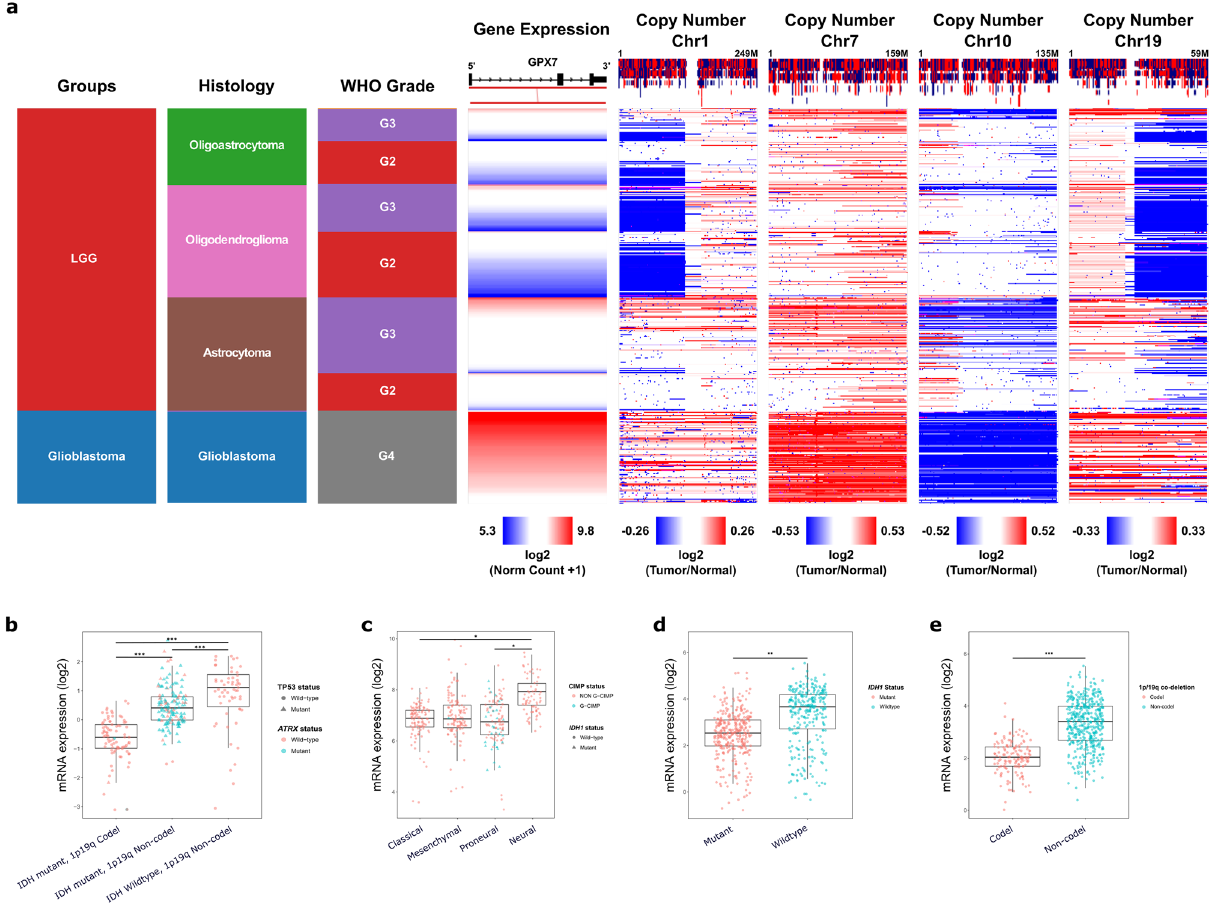
Figure 3. GPX7 expression was correlated with CNAs (Copy Number Alterations), IDH1 mutational status and 1p/19q co-deletion. ( a ) Heatmap integrating GPX7 expression (Log2—Norm Count + 1), CNAs (Copy Number Alterations) status (Log2—Tumor/Normal) of chromosomes 1, 7, 10 and 19, histology and WHO grade of LGG and GBM cohorts from TCGA. GPX7 mRNA expression in molecular subtypes of ( b ) Low-Grade Gliomas (LGG) cohort, according to WHO 81 ( IDH -mutant, 1p/19q codeleted; IDH -mutant, 1p/19q non-codeleted; and IDH -wildtype, 1p/19q non-codeleted group) and of ( c ) GBM cohort, according to Verhaak 82 (Proneural; Classical; Mesenchymal; Neural) from TCGA database. ( d ) GPX7 expression correlates with IDH-1 status in CGGA gliomas. ( e ) GPX7 expression correlates with 1p/19q co-deletion in CGGA gliomas. * p < 0.05, ** p < 0.01, *** p <